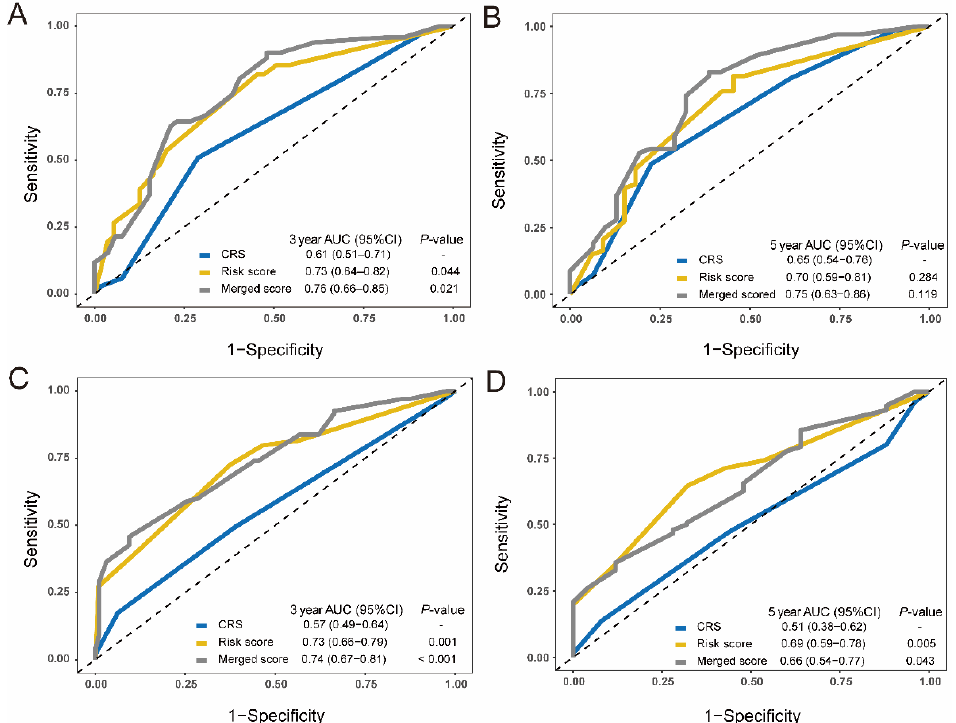
Figure 4. Comparisons of the prognostic accuracy among the CRS system, exosomal miRNA score, and merged score. ( A , B ). Time-dependent ROC curves are drawn in the training cohorts. The 3-year AUCs ( A ) and 5-year AUCs ( B ) of overall survival were calculated for the CRS, 4-exosomal miRNA risk score, and a merged score that was constructed by the CRS and exosomal miRNA risk score. ( C , D ) Time-dependent ROC curves of the CRS, exosomal miRNA risk score and the merged score in the combined validation cohorts. The 3-year AUCs ( C ) and 5-year AUCs ( D ) of overall survival were evaluated for the three score systems. The AUC of the CRS system was identified as the con- trol. The two-sided p -values were calculated through the bootstrap test. ROC, receiver operating characteristic; AUC, area under the curve; CRS, clinical risk score.